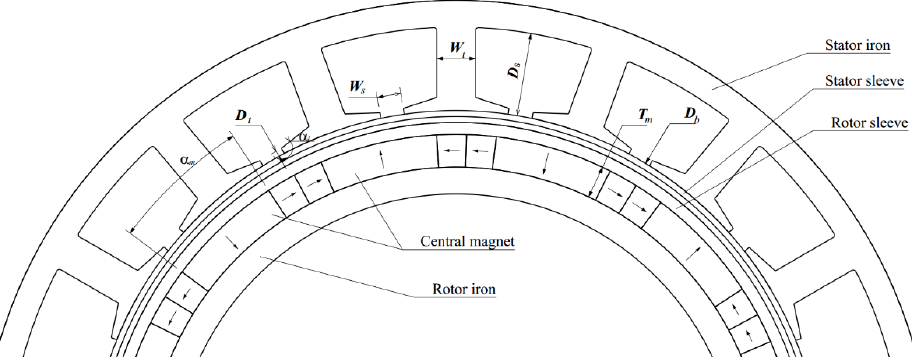
Figure 3. Schematic of the rotor assembly.